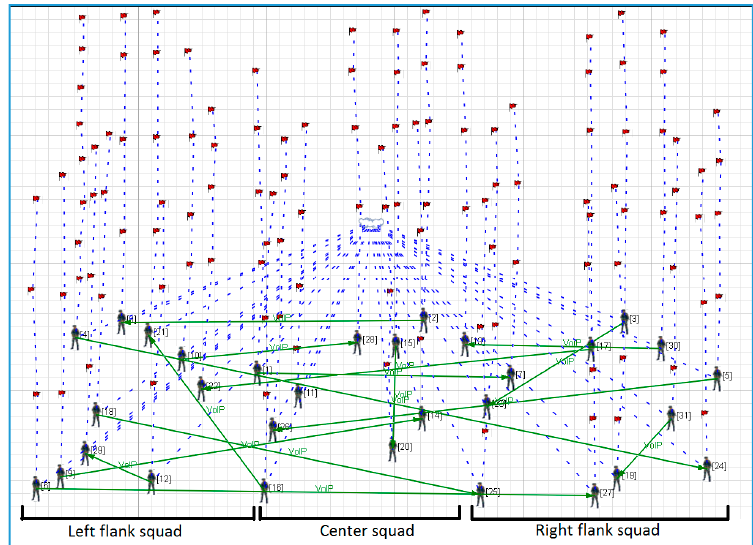
Figure 13. Platoon scenario line deployment.